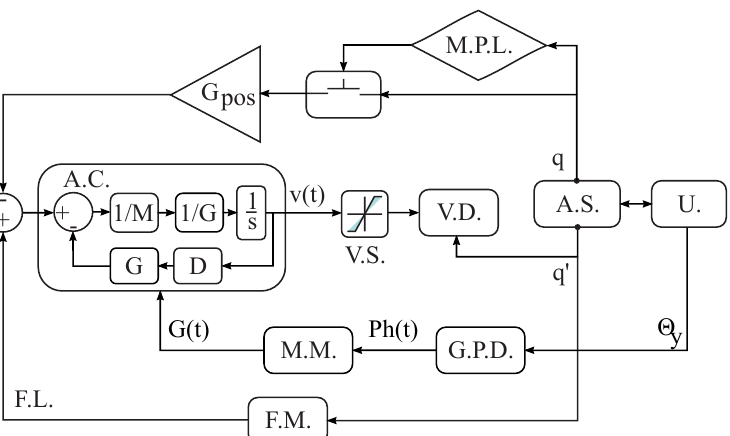
Figure 4. Controller scheme of the assistance mode. The admittance controller’ model is defined as a mass-damper system, including a module of position limitation, velocity saturation, and emergency button. These modules are aimed at the device’s security. (A.C.: Admittance Controller, F.L.: Feedforward Loop, F.M.: Friction Model, M.M.: Modulation Method, G.P.D.: Gait Phase Detection, U.: User, A.S.: Actuation System, V.D.: Velocity Driver, V.S.: Velocity Saturation, P.L.: Position